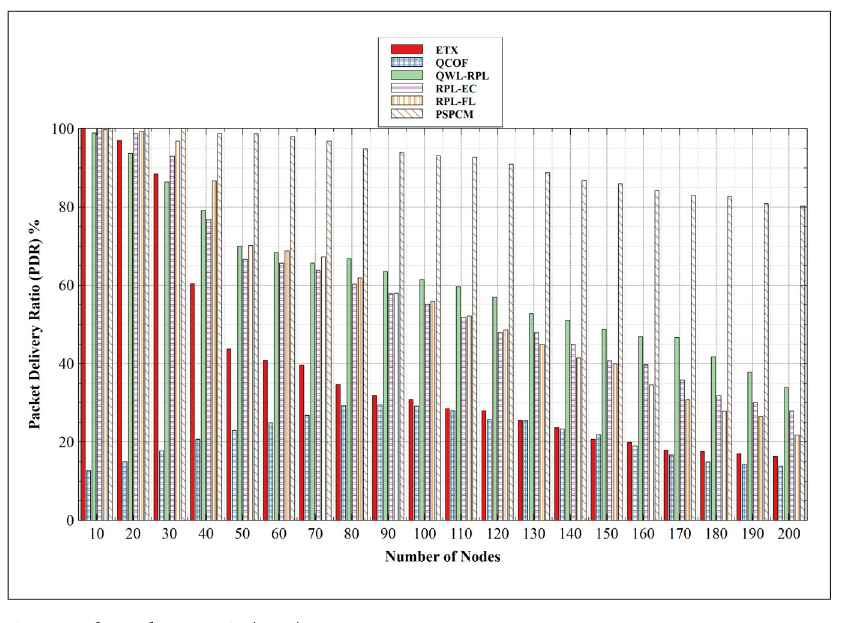
Fig 16. Packet Delivery Ratio